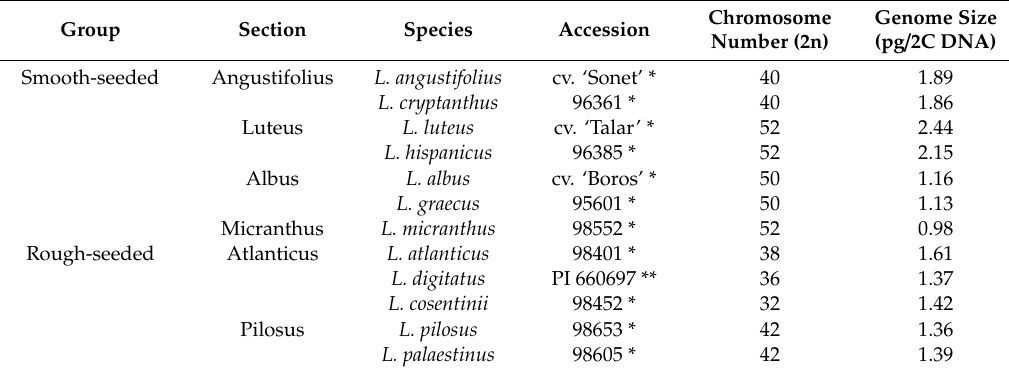
Table 1. General characteristics of the Lupinus species used in this